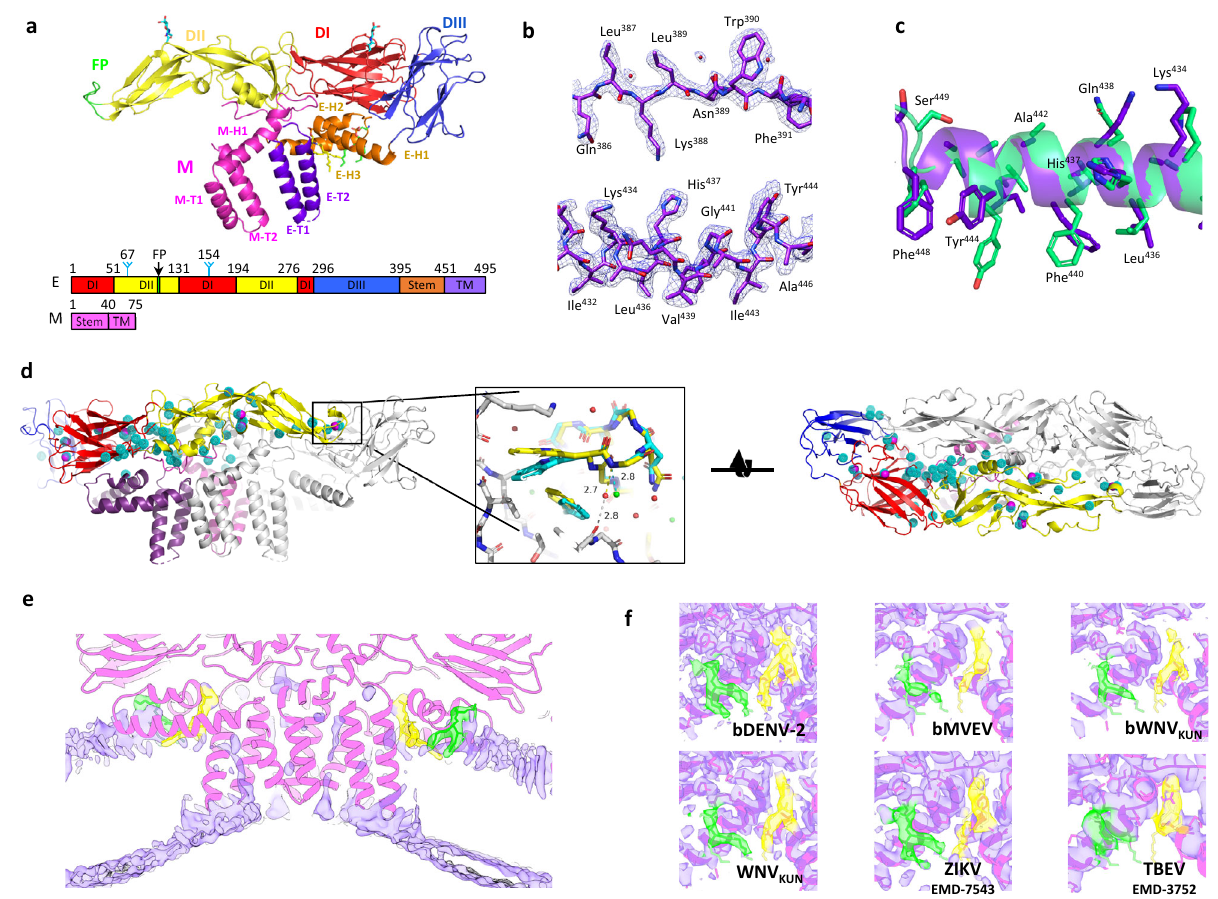
Fig. 8 Modelling high-resolution features in bDENV-2. a A cartoon representation of the bDENV-2 structure coloured by domain according to the domain diagram below. The N-linked glycans are shown in cyan. b Zooms of the density (mesh) and fi t of the bDENV-2 structure (purple sticks). Water molecules are shown as red spheres. c Overlay of E-H3 of bDENV-2 (purple) and DENV-2 (green, PDB: 3J27). Side chains are represented as sticks and the main chain as a cartoon. d Orthogonal views of the E dimer. Out of ~150 water molecules, 59 are conserved in all prM-E heterodimers within the particle and are represented as cyan dotted spheres. When compared to a crystal structure of similar resolution (PDB: 3C5X), 11 are conserved and are represented as solid, magenta spheres. The inset represents a zoom on the fusion loop highlighting a conserved water molecule. Water molecules are shown as red and green spheres for the cryo-EM structure and crystal structure, respectively. e A cartoon representation of an E – M dimer in bDENV-2 (magenta) subtracted from the reconstruction to produce a difference map (purple). The difference map was low-pass fi ltered for clarity and the density surrounding the two lipid molecules is highlighted (yellow and green). f A comparison of the density near the pocket factors in bDENV-2, bMVEV, bWNV KUN , WNV KUN , ZIKV (EMD-7543, PDB: 6CO8) and TBEV (EMD-3752, PDB: 5O6A). The structure of the E protein and surrounding density is displayed in magenta. The structure of the lipids from bDENV-2 is displayed in each panel as sticks (green and yellow) and density within 2 Å is coloured